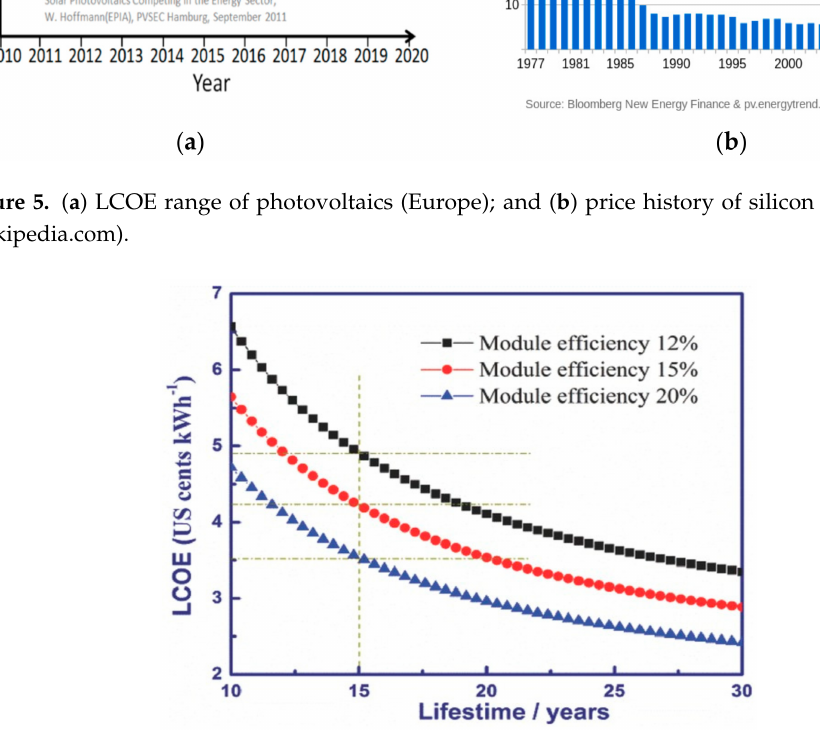
Figure 6. Effect of lifetime on LCOE, as a function of efficiency. As the lifetime increases, the LCOE goes drastically down but should reach a saturation point at the end (taken from Cai et al.